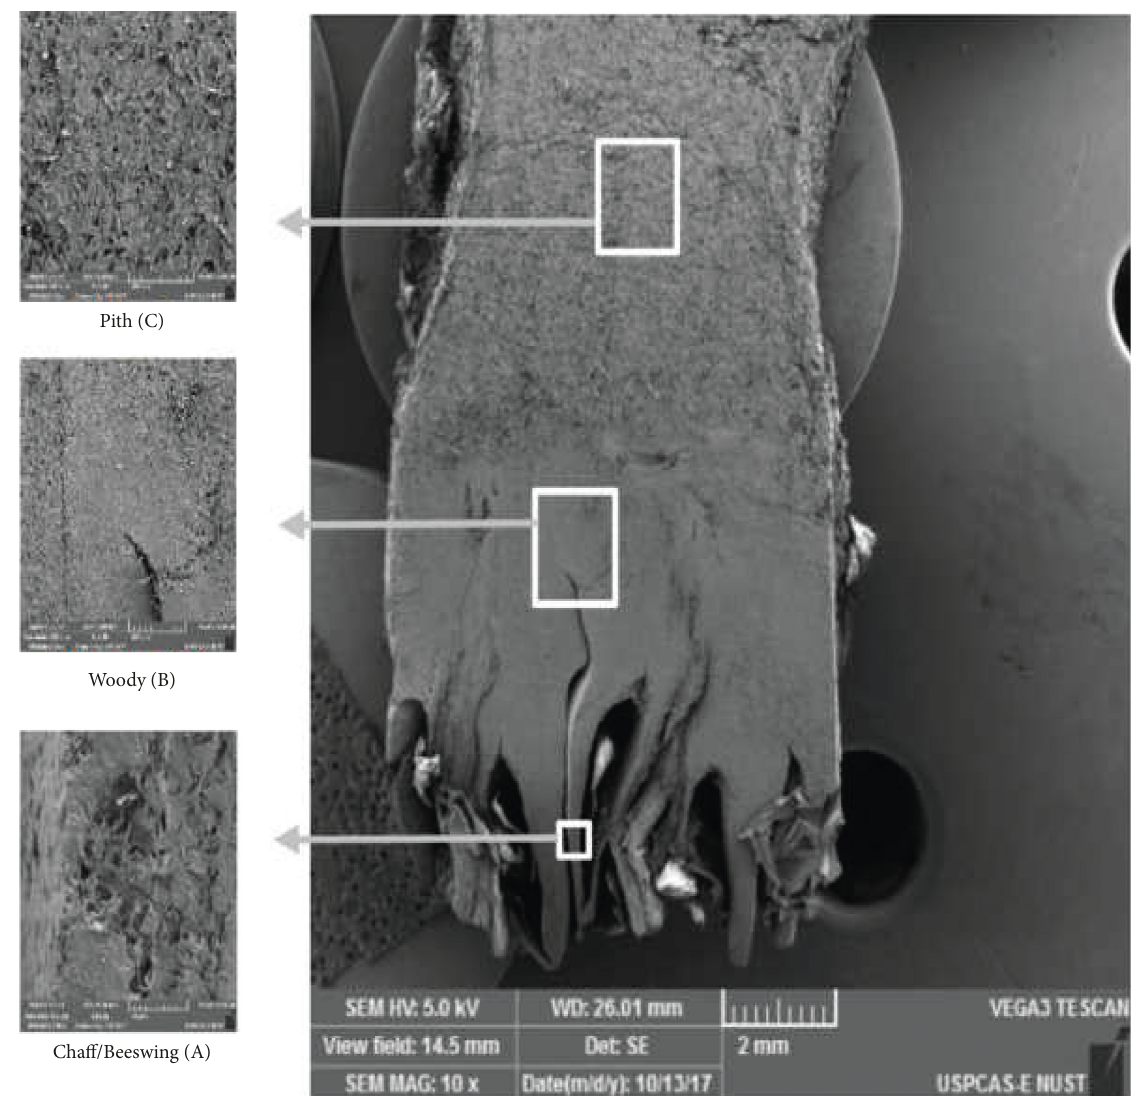
Figure 8: SEM micromorphology of corncob leaf ashes